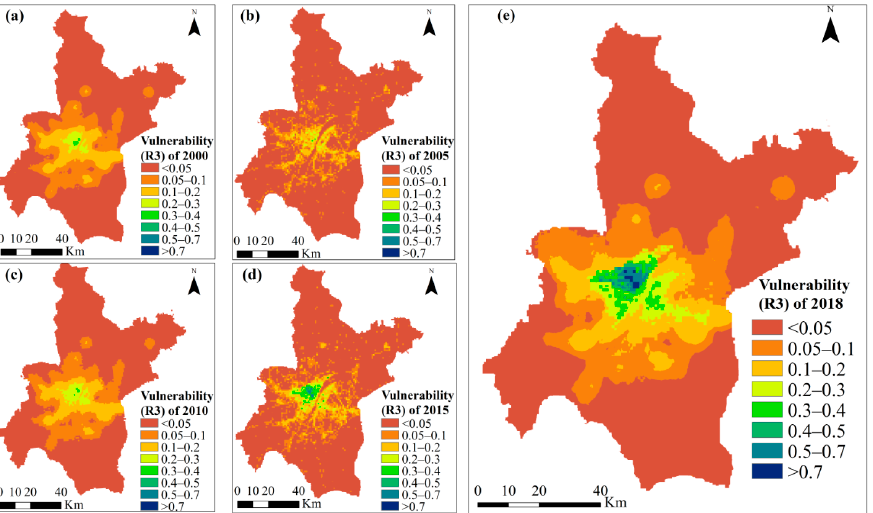
Figure 7. Spatiotemporal patterns of flood vulnerability in Wuhan (( a ) 2000, ( b ) 2005, ( c ) 2010, ( d ) 2015, ( e ) 2018).